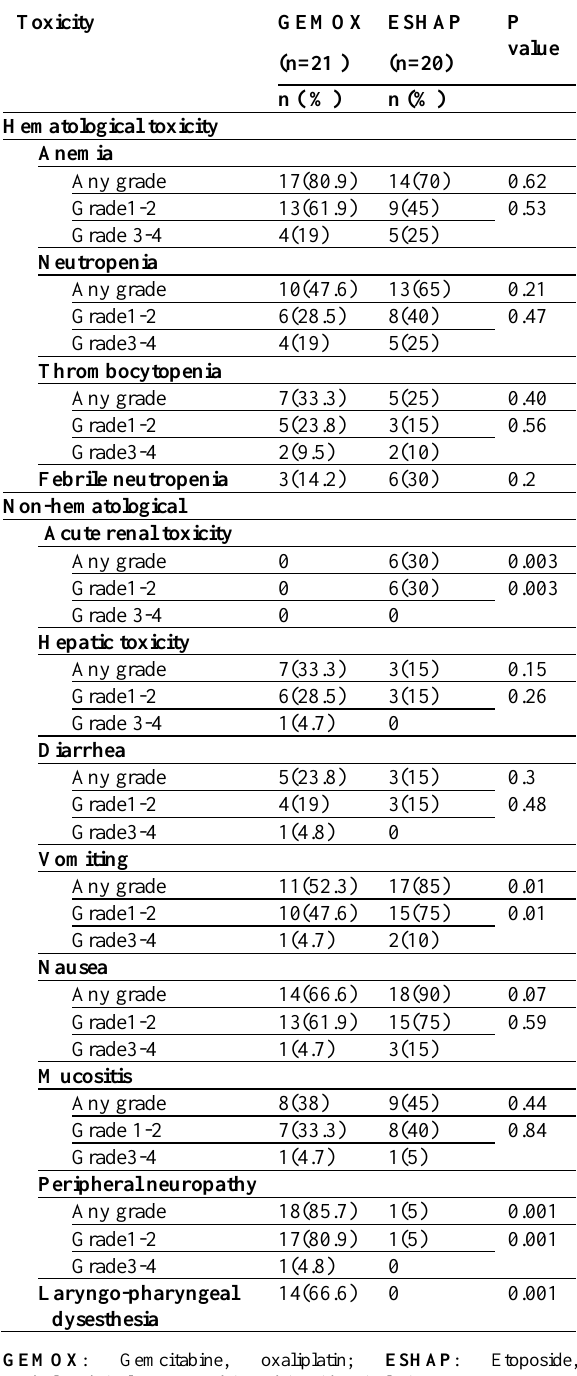
Table 4. Toxicity profile of the two treatment